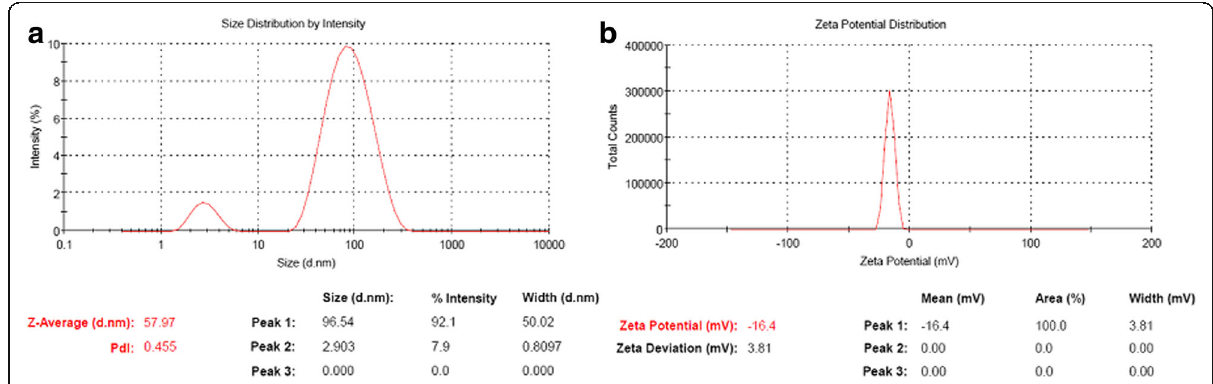
Fig. 3 a Particle size distribution by intensity of the Au-CSCaCO 3 NPs. b Zeta potential of the Au-CSCaCO 3 NPs showing the surface